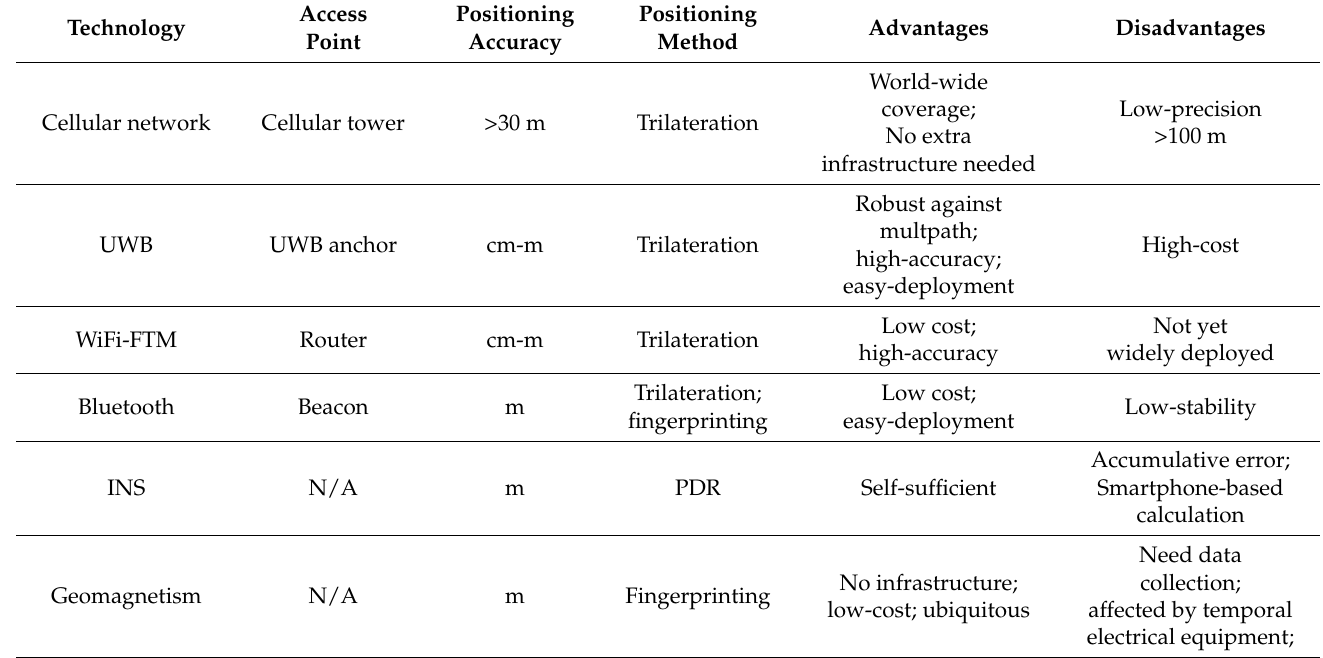
Table 2. Overview of indoor positioning